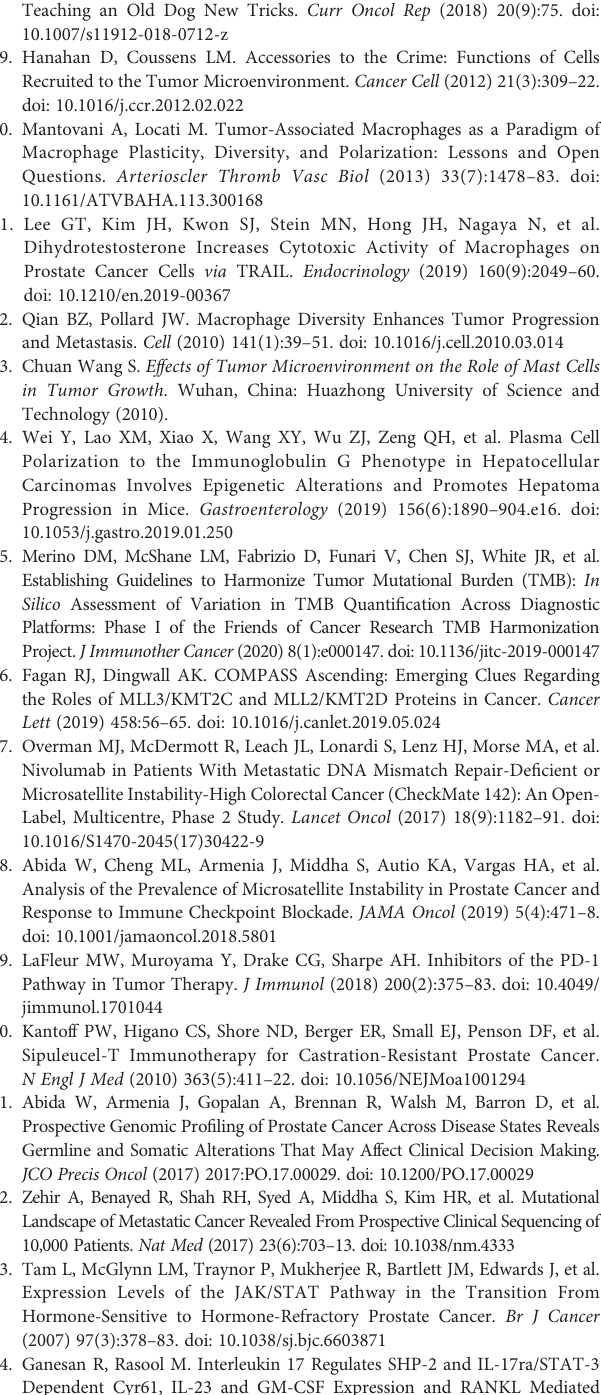
Supplementary Figure2 | (A) Bioinformatics methodwas used toinvestigatethe relationship between the progression of prostate cancer and the immune microenvironment in591 prostate cancersamplesfrom theTCGAandGEO cohort. (B) Identi fi cation of genes related to the immune microenvironment in advanced